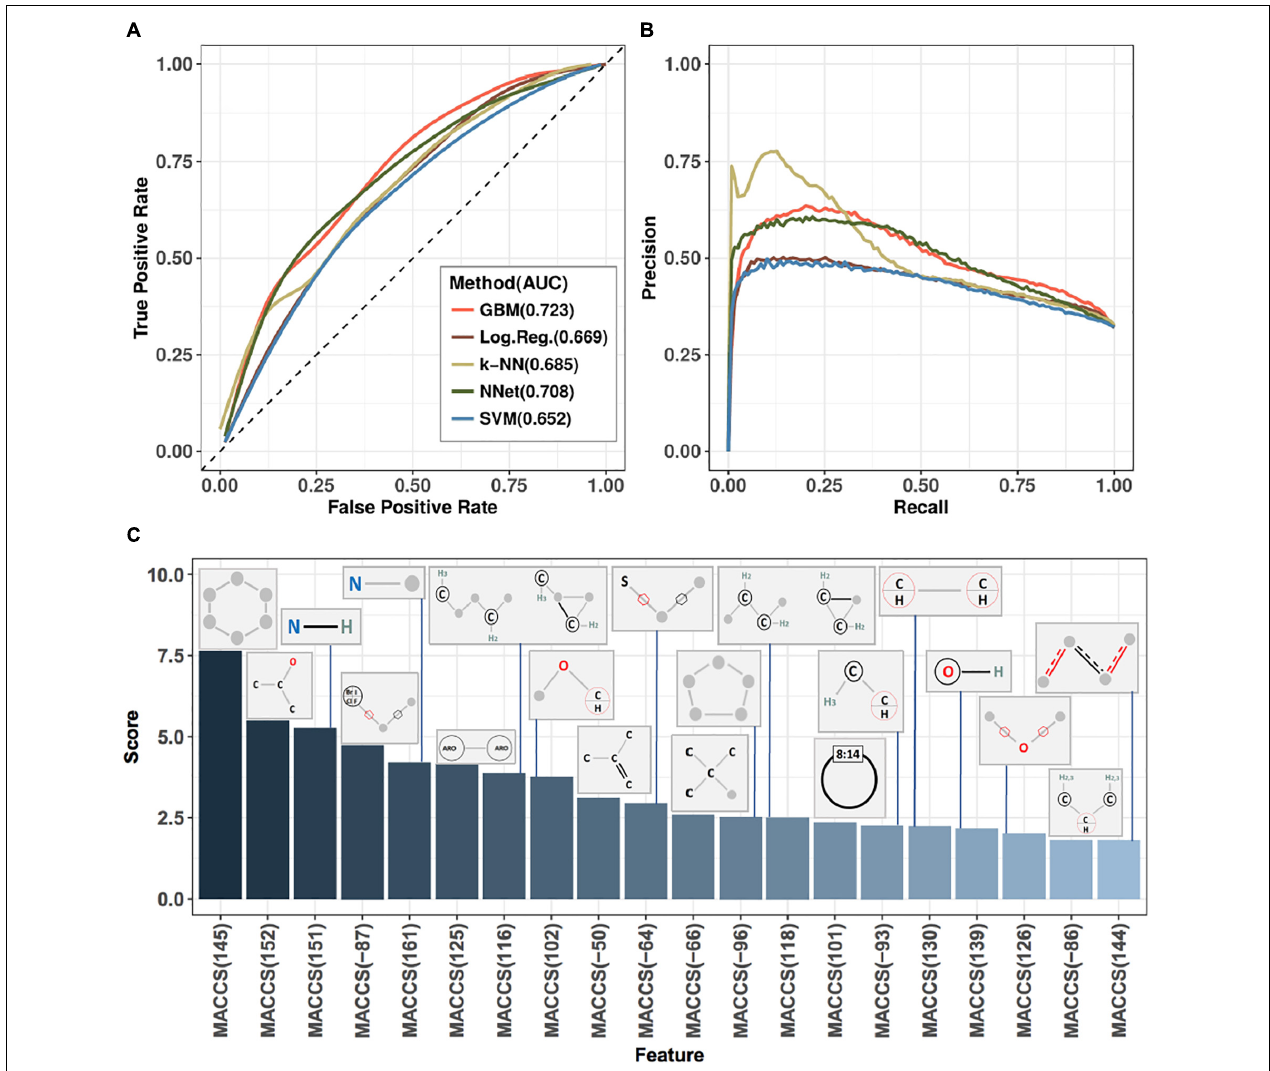
FIGURE 3 | Performance metrics and analysis of substructure-based prediction of relative efficacy against ABC-16 yeast. (A) ROC curves estimating performance of five machine learning algorithms evaluated in ten-fold cross-validation. Each algorithm was trained over a grid of meta-parameter values, and the final predictions for any given test fold were computed by averaging predictions from individual models across this grid. Area under the curve (AUC) values are indicated next to method annotations. (B) Precision-recall curves for the five machine learning algorithms presented in panel (A) . GBM was selected as the top-performing method, based on AUC and accuracy metrics ( Table 1 ). The method corresponds to the light red line in both panels (A) and (B) . (C) Feature importance scores from a Gradient Boosting Machine model trained on the entire training set using the best set of meta-parameter values (as determined from ten-fold cross-validation). Presented are the top 20 features and their associated MACCS